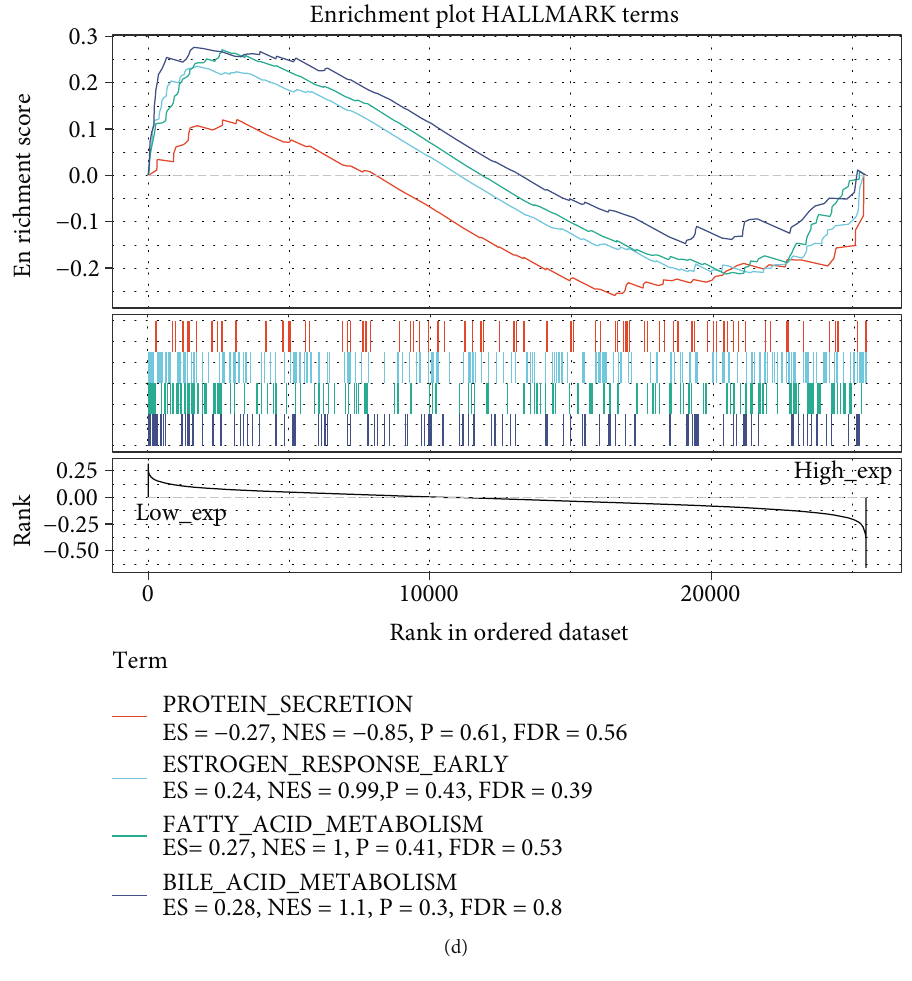
Figure 12: (a – d) KEGG and HALLMARK terms of B4GALNT1 in diverse